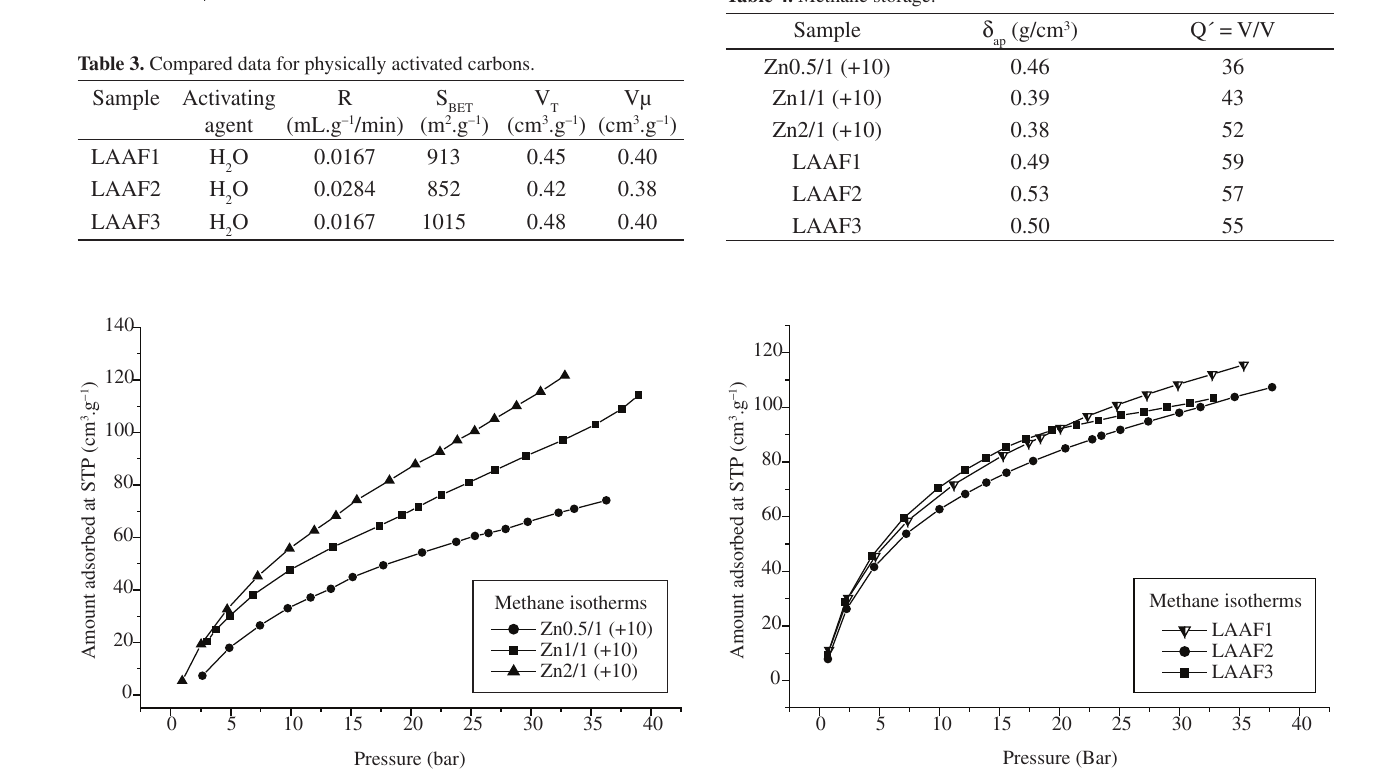
Figure 7. Methane isotherms for the samples activated with ZnCl